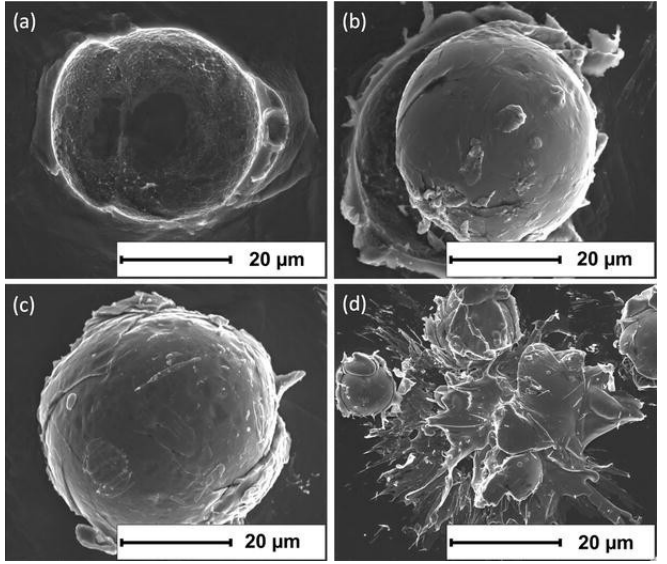
Figure 13. Different classes of particle deformation. ( a ) No bonding, ( b ) weak bonding, ( c ) good bonding, and ( d ) viscous flow. Reprinted with permission from [43] Copyright 2021 Springer.